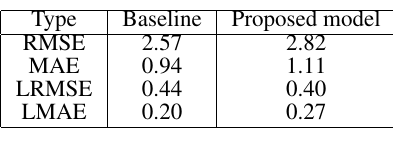
Table 2. Counting results on the test set of the high resolution dataset.